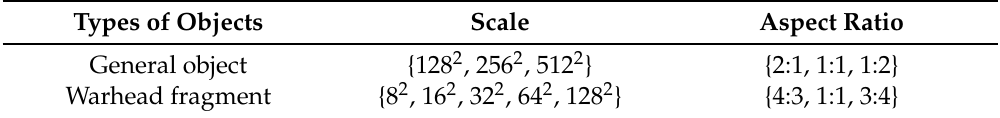
Table 1. The hyper-parameters of the anchor